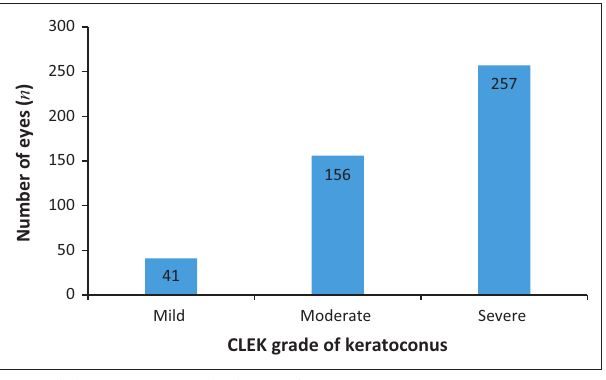
CLEK, Collaborative Longitudinal Evaluation of Keratoconus. FIGURE 2: Number of keratoconus eyes according to the Collaborative Longitudinal Evaluation of Keratoconus TABLE 1: Mean values and standard deviations for age and corneal characteristics in the three grades of keratoconus. Variables